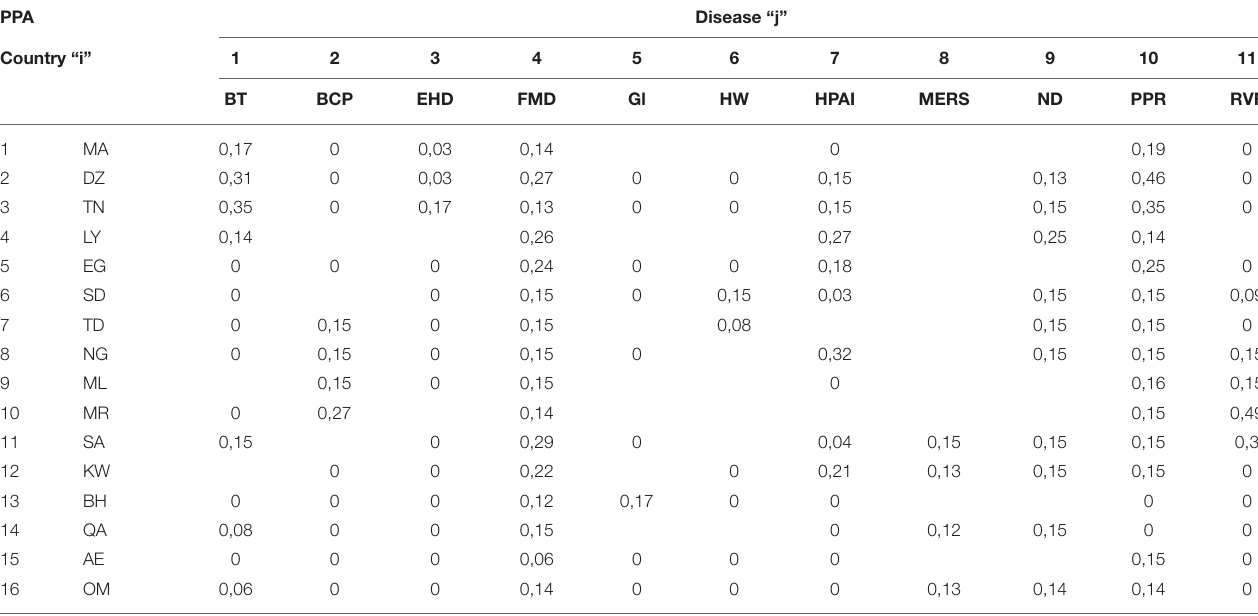
TABLE 3 | Probability of the country i being affected by the disease j ( PPA j i ). PPA Disease